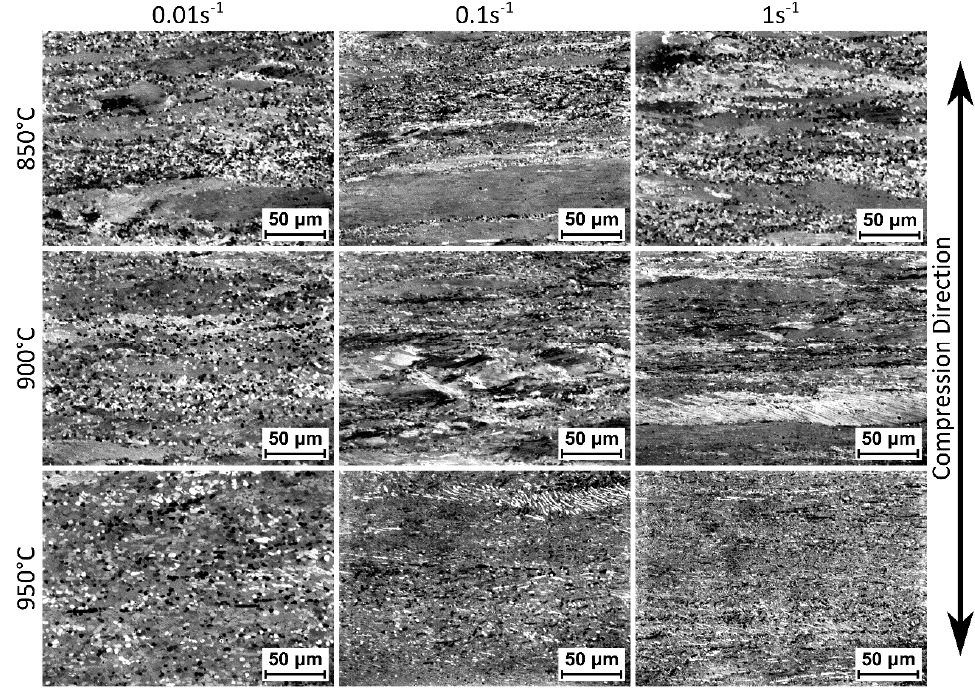
Figure 8. Cross-polarized light micrographs of higher-strain central regions in Ti-6Al-4V swarf specimens consolidated via FAST at 1200 °C for 30 min after a subsequent hot compression at 850, 900, or 950 °C, and a strain rate of 0.01, or 0.1, or 1 s − 1 (as labelled).